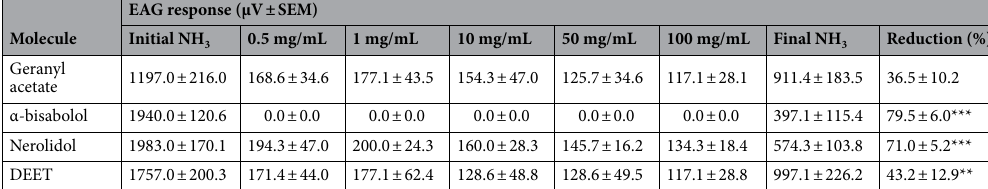
Table 1. Electroantennography signals (microvolts ± standard deviation, µV ± SEM) for the repellent compounds: geranyl acetate, α-bisabolol, nerolidol, and DEET with a pre- and post-treatment ammonia stimulus. For each molecule and concentration, the percentage changes in the values regarding the pre- and post-treatment ammonia signal are shown. (**) and (***) indicate statistically significant differences comparing the EAG ammonia signals before and after applying the repellent molecules in the EAG essays. One way ANOVA, (**) p < 0.01; (***) p < 0.001, post hoc Tukey test.